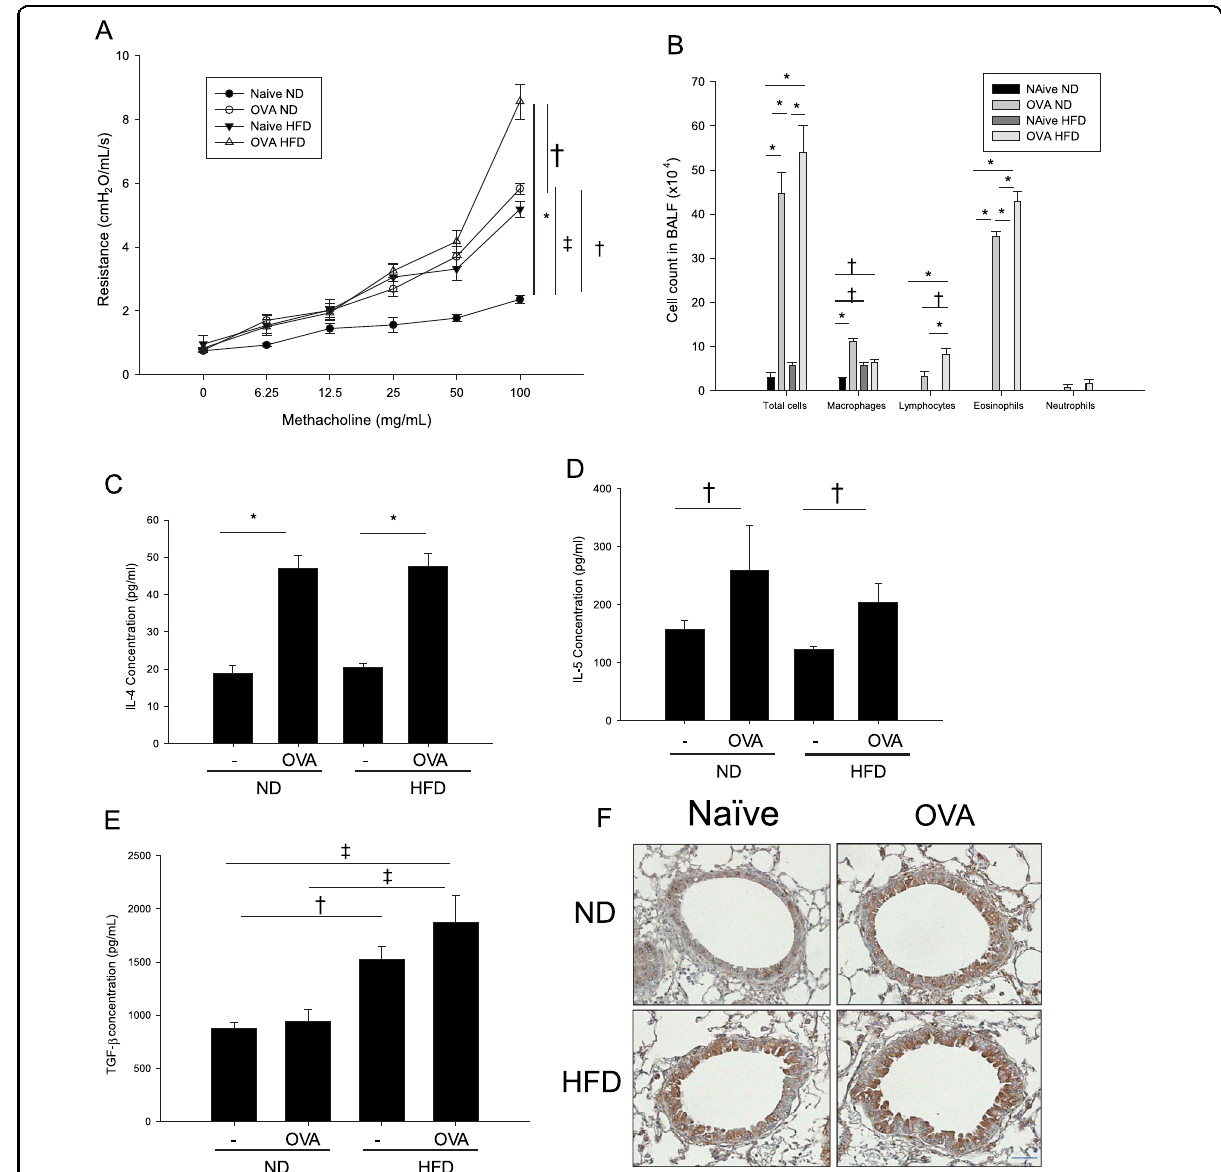
Fig. 3 AHR and in fl ammatory features of naive HFD and OVA-HFD models. AHR to MCh ( a ), in fl ammatory cell pro fi le in the BALF ( b ), IL-4 ( c ) and IL-5 levels ( d ), and TGF- β 1 ( e ) concentrations in lung homogenates. Immunohistochemical staining for TGF- β 1 (F) in tissue from naïve HFD, OVA-HFD, naive ND, and OVA-ND mice are shown. † P < 0.05; ‡ P < 0.01; * P < 0.001. AHR airway hyperresponsiveness, MCh methacholine, BALF bronchoalveolar lavage fl uid, HFD high-fat-diet, IL interleukin, OVA ovalbumin, ND normal diet, TGF transforming growth